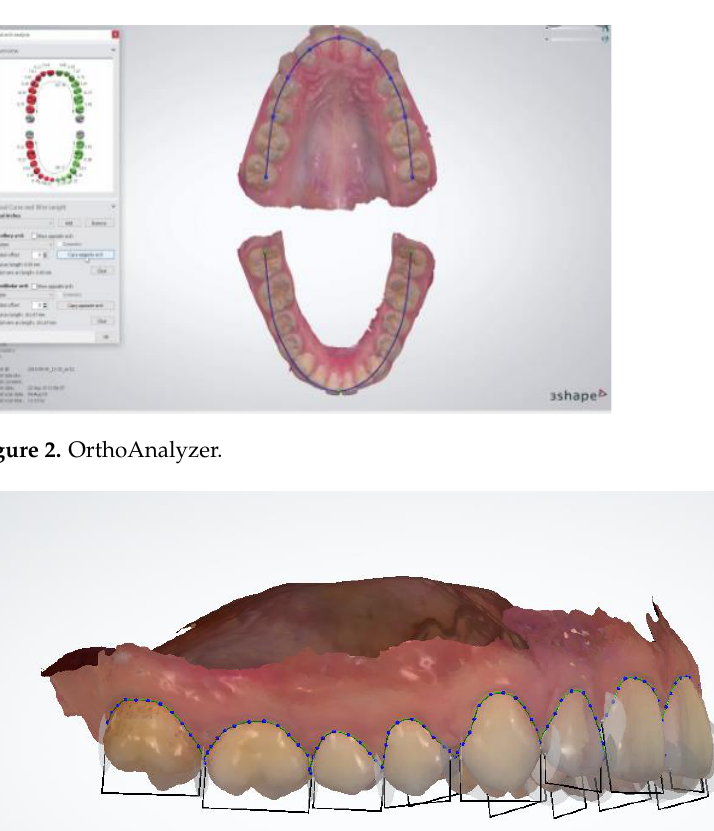
Figure 3. Mesial-distal width, OrthoAnalyzer.